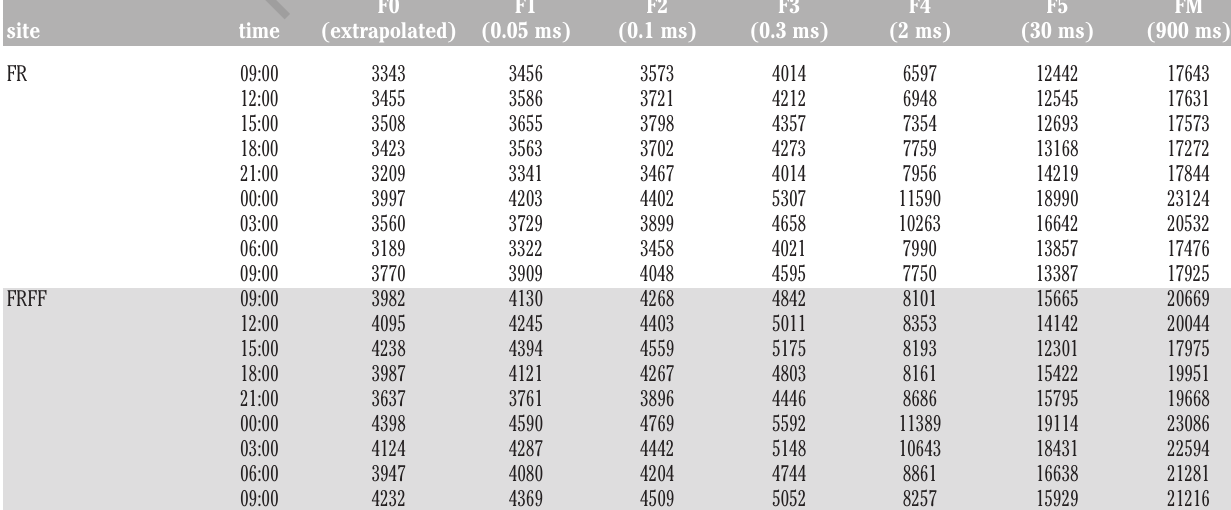
Table 3. Mean values of raw fluorescence intensities of the Pocket-PEA measurements at T0-T5 and for the maximum fluorescence (FM) for all data points in Figures 1-2 obtained at the Frankfurt site outdoors (FR) and at the Frankfurt site under frost-free conditions (FRFF); Measuring Date